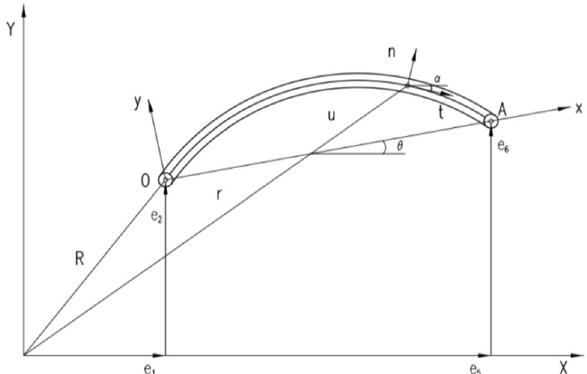
Figure 1. Plane deformation beam element.